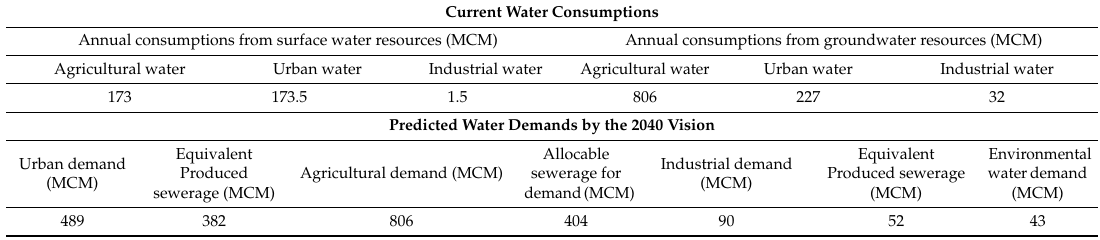
Table A2. Water consumptions and water demands for the Kashafroud watershed by 2040